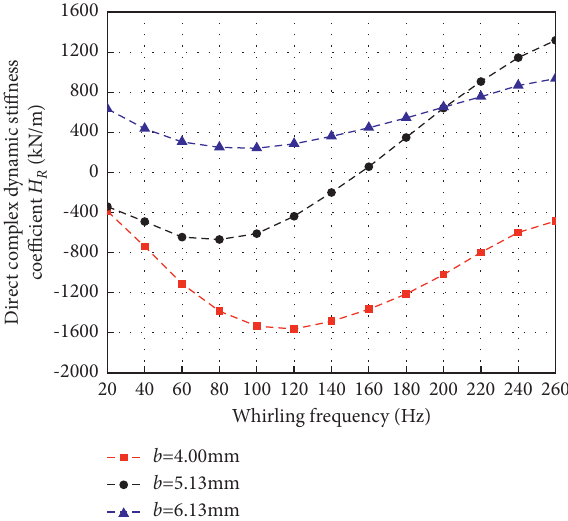
Figure 20: Direct complex dynamic stiffness coefficient vs. whirling frequency.